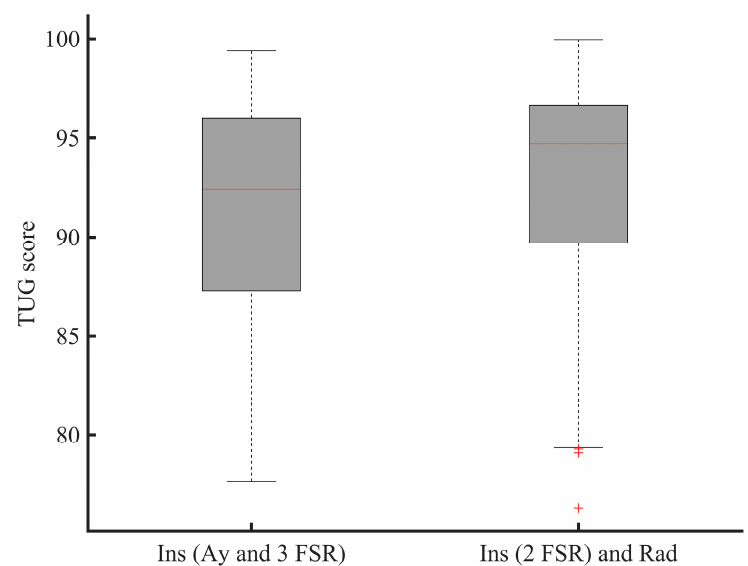
Figure 11. The TUG score of the participant performing the TUG tests. The data from the walking and turning phases of this test are exploited (FSR: force sensitive resistor; 3 FSR: use of three FSRs; 2 FSR: use of two FSRs).